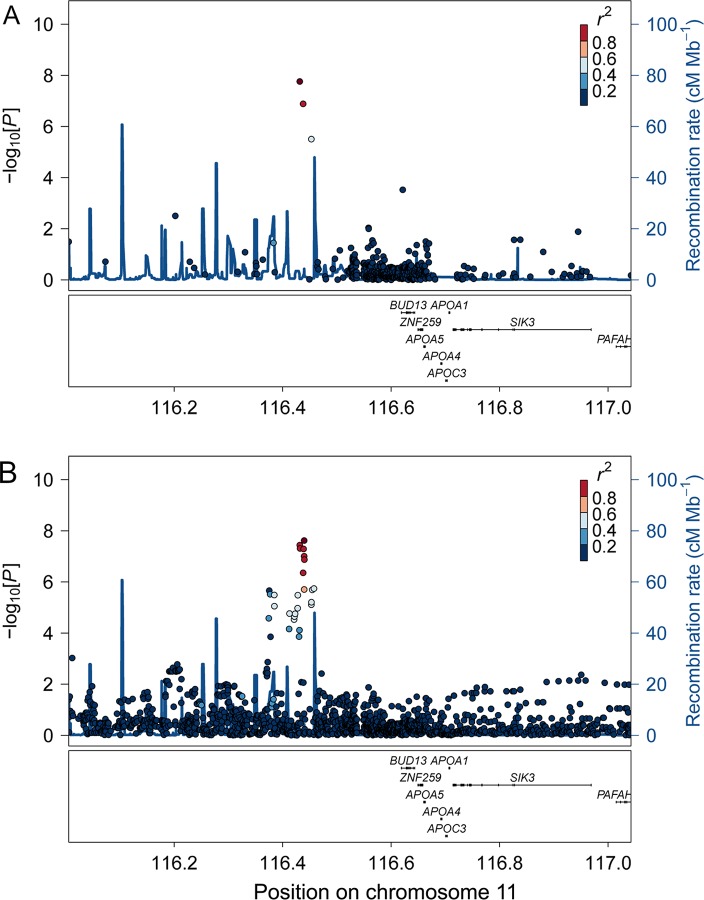
Regional BMI-association results.The plots are based on Metabochip data (A) or imputed data (B). The dark red dot in each plot indicates the lead SNP in the region (A, rs4936356; B, rs7928307), the rest of the SNPs are colored according to the extent of correlation (r2) with the respective lead SNP.